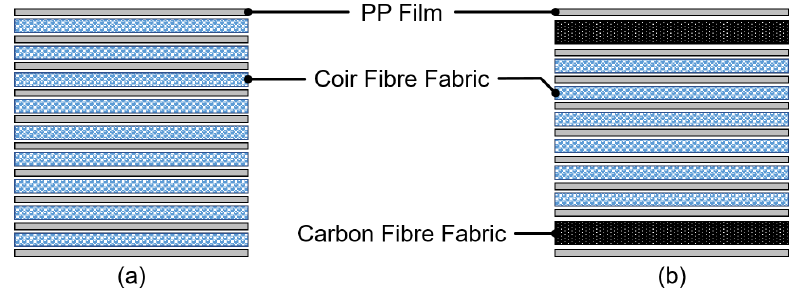
Figure 2. Schematic representation of the fibre stacking sequence for ( a ) the coir fibre-reinforced polypropylene (Coir-PP) ear cups; and ( b ) the coir/carbon fibre-reinforced polypropylene (Coir/C-PP) ear